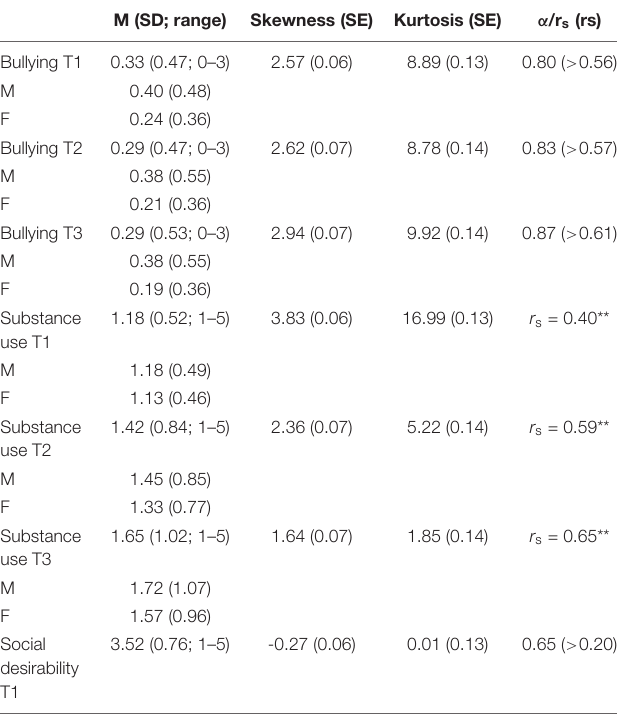
TABLE 2 | Descriptive statistics of the scales at the three measurement points and results from the reliability analysis. M (SD; range) Skewness (SE) Kurtosis (SE) α /r s